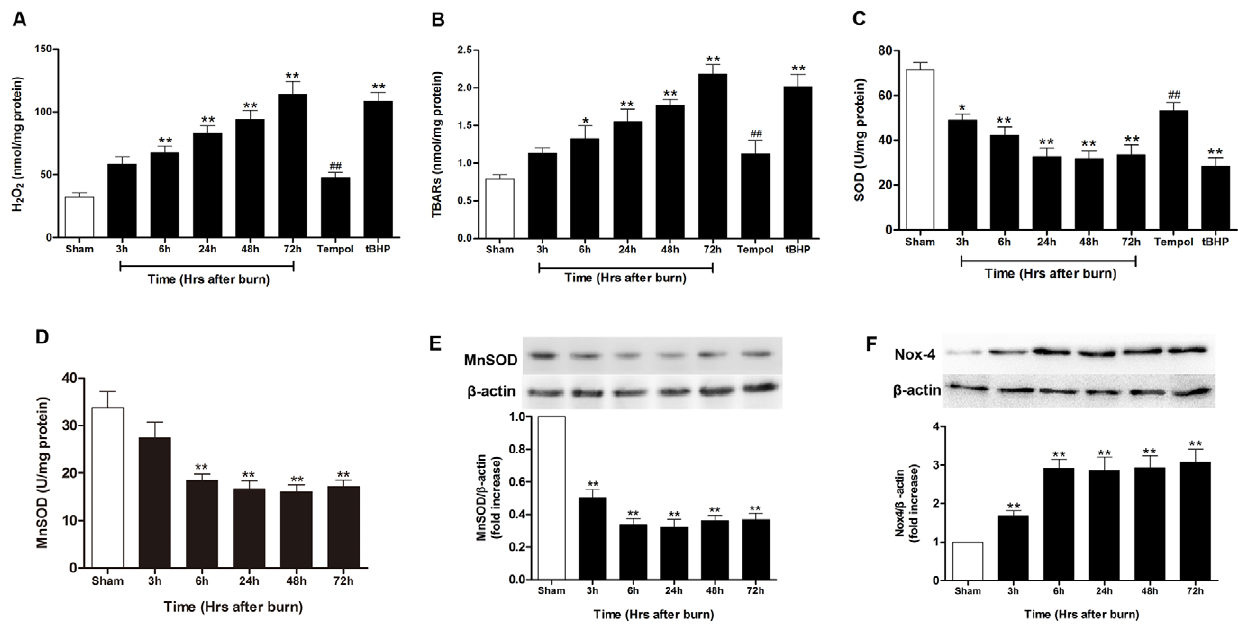
Figure 4. Induction of oxidative stress in kidneys of rats postburn. Burn injury induced sustained ROS generation evidenced by increased renal ( A ) H 2 O 2 production, ( B ) thiobarbituric acid-reactive substances (TBARS) generation, suppressed antioxidant activity evidenced by decreased ( C ) SOD level and at 3 h, 6 h, 24 h, 48 h and 72 h after burn, which were attenuated by tempol at 72 h after burn. Renal ( D ) MnSOD activity and ( E ) protein expression, and ( F ) Nox4 expression was analyzed to determine the mitochondrial status. Treatment with tBHP also induced significant oxidative stress in kidneys of sham rats. * P , 0.05, ** P , 0.01 vs. Sham; ## P , 0.01 vs. Vehicle (72 h). n=6 rats per group per time point.